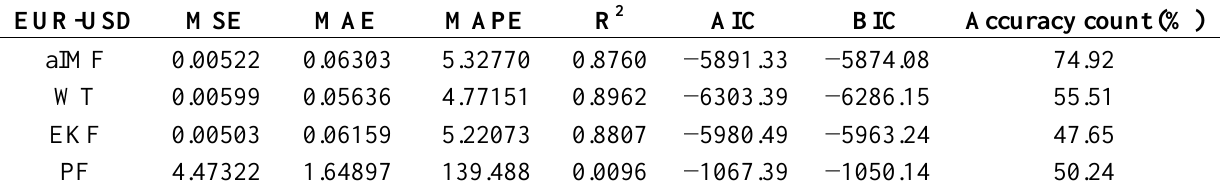
Table 3. Performance measurements of original datasets using noise distribution at 100% with 5 Hz and 10% amplitude of the original